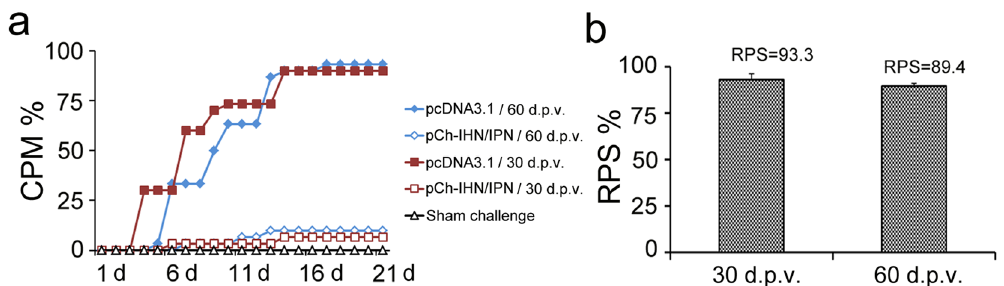
Figure 2. Cumulative percentage mortality (CPM) curves for pCh-IHN/IPN-vaccinated rainbow trout challenged with IHNV strain Sn1203 at 30 or 60 d.p.v. Rainbow trout injected with plasmid pcDNA3.1 (vector) were used as the negative controls. Duplicate groups of 30 fish were challenged with an intraperitoneal injection of 10 2 plaque-forming units of IHNV Sn-1203 per fish. No mortality was observed in the sham-infected control group, and no significant differences were observed in mortality between any replicates within any treatment